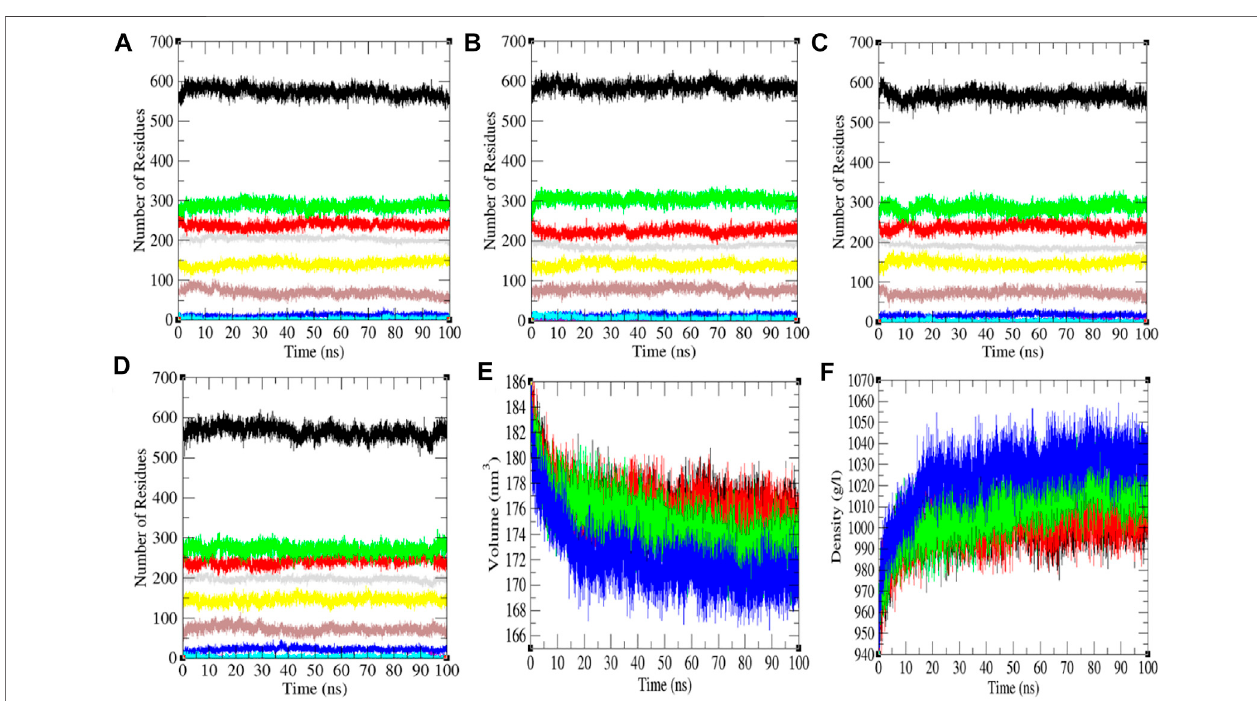
FIGURE 4 | The secondary structure conformations. The secondary structure plot of the SARS-CoV-2 S protein at (A) 0 ° C, (B) 20 ° C, (C) 40 ° C, and (D) 60 ° C, respectively. (E) Volume and (F) density of SARS-CoV-2 spike protein. The color codes have the same meaning as described in Figure 2